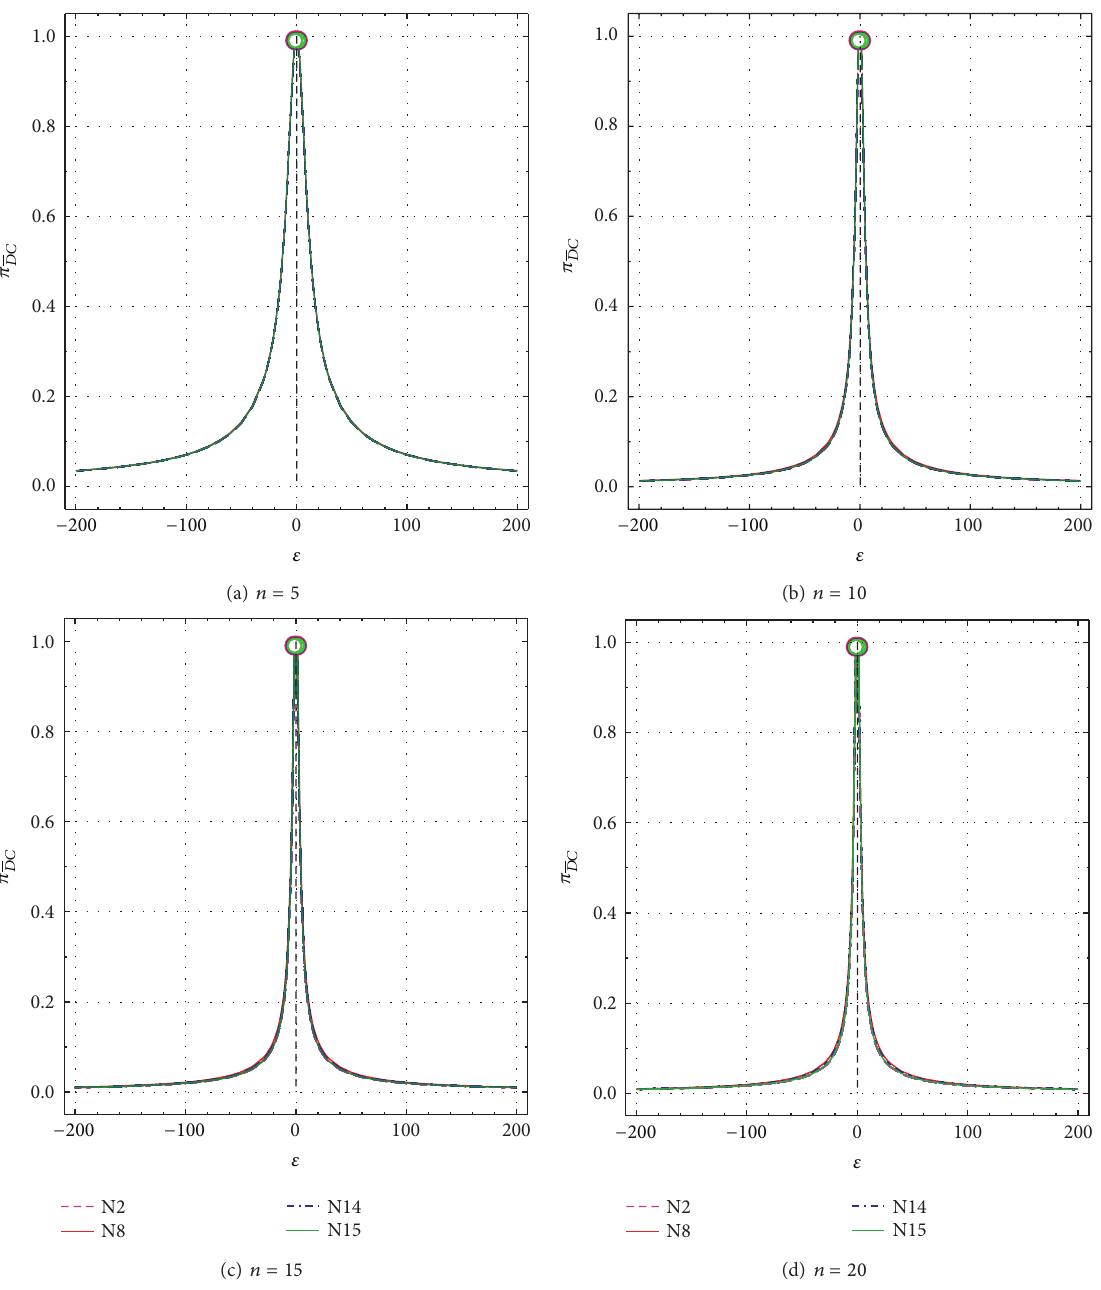
Figure 7: Nonspurious type II error probability ( 𝜋 𝐷𝐶 ) as a function of 𝜀 from − 1 to − 200 and +1 to +200 for all tests N2, N8, N14, and N15. 𝜀 = ±1 ) are shown by open circles. (a) 𝑛 = 5 ; (b) 𝑛 = 10 ; (c) 𝑛 = 15 ; and (d) 𝑛 = 20 . 𝜋 𝐷𝐶 values for uncontaminated samples (